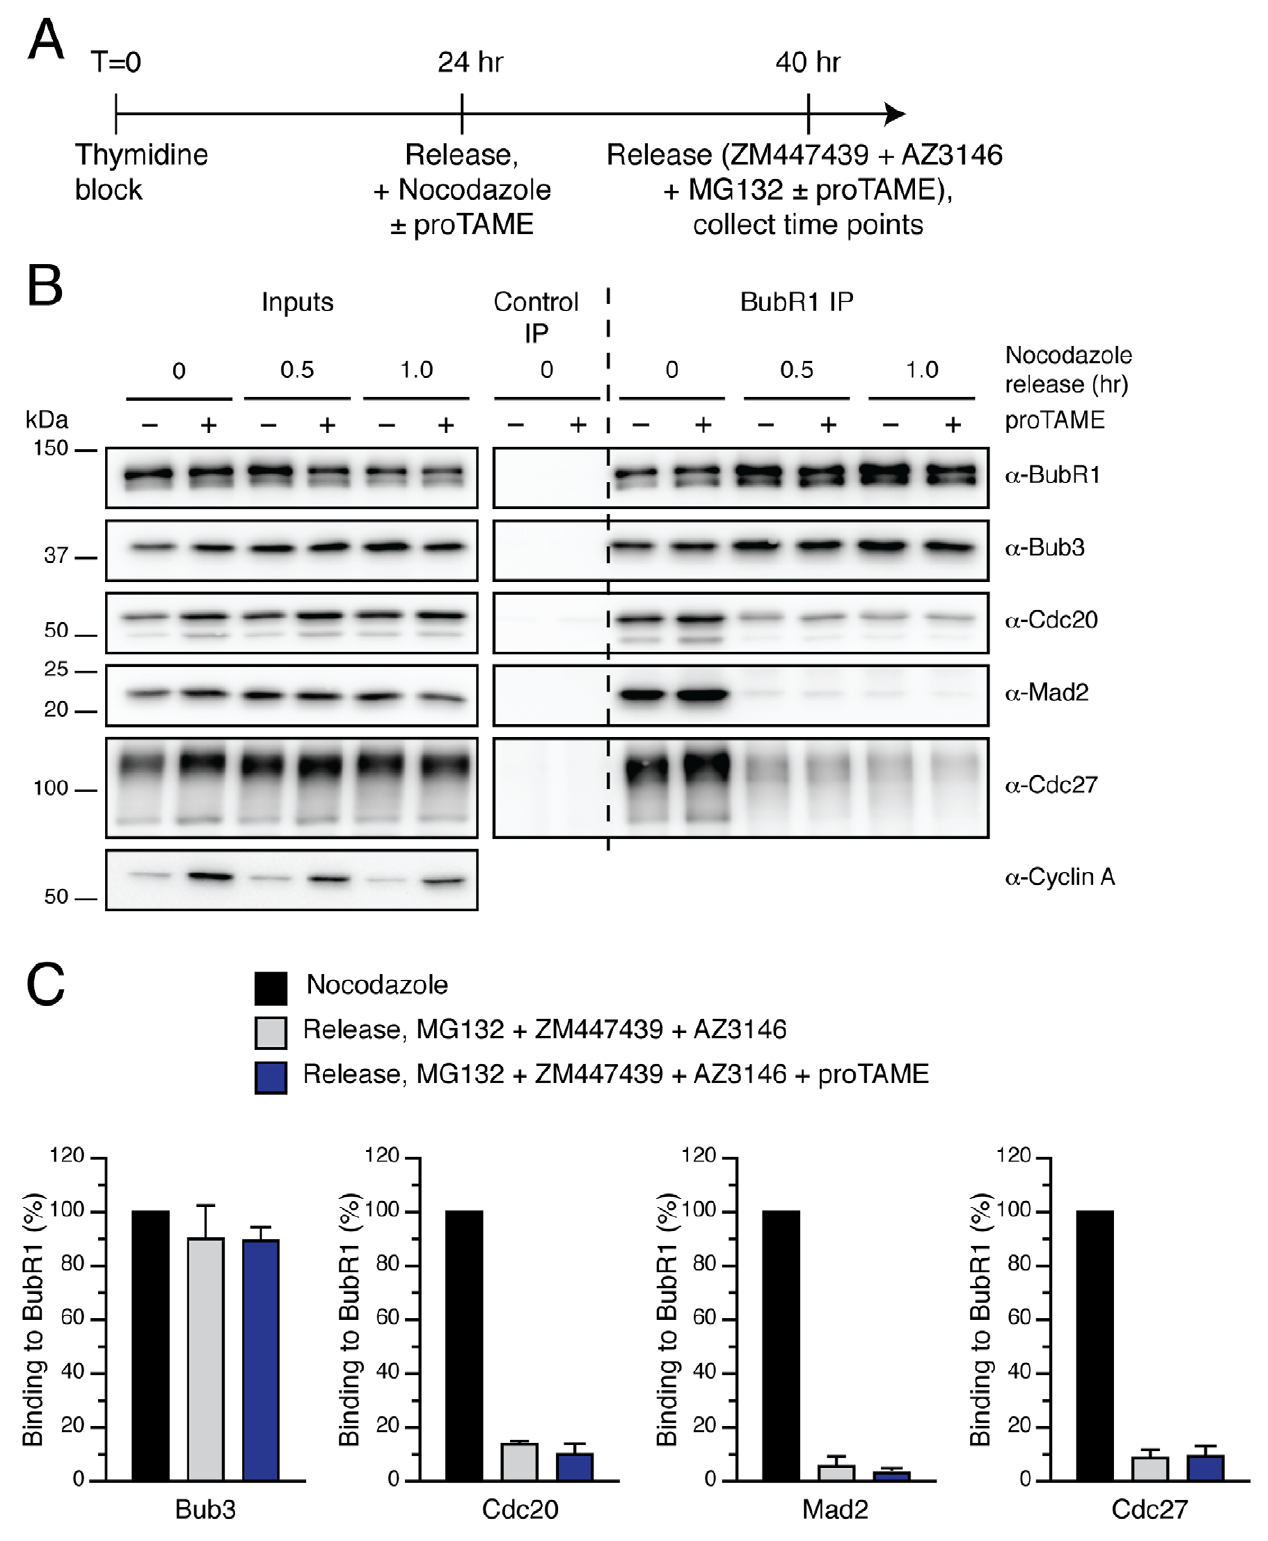
Figure 6. proTAME treatment does not prevent MCC turnover. ( A ) Timeline showing the experimental strategy. ( B, C ) Immunoblots of BubR1 immune complexes isolated from mitotic HeLa cells arrested with nocodazole and released into media containing MG132, ZM447439 and AZ3146, in the presence or absence of 20 m M proTAME. Cyclin A was used as a marker for lack of APC/C activity. ( C ) Bar graph quantifying the experiment in (B). Values represent the mean 6 s.e.m. of three independent experiments.